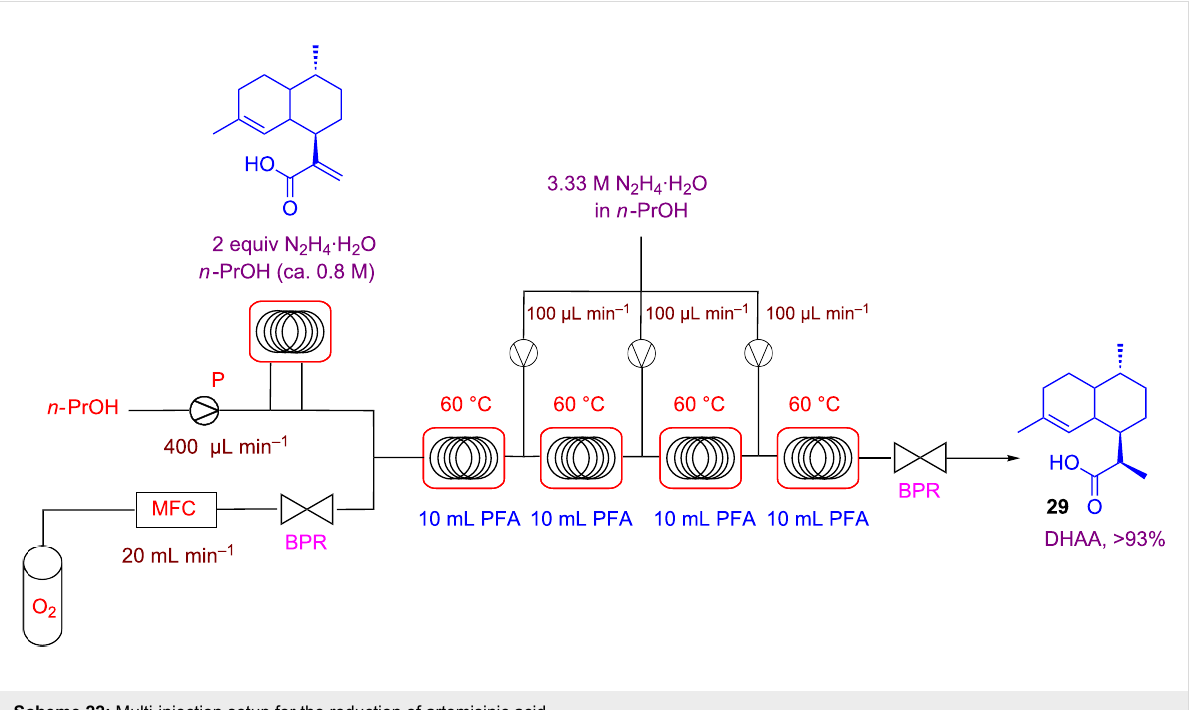
Scheme 22: Multi-injection setup for the reduction of artemisinic